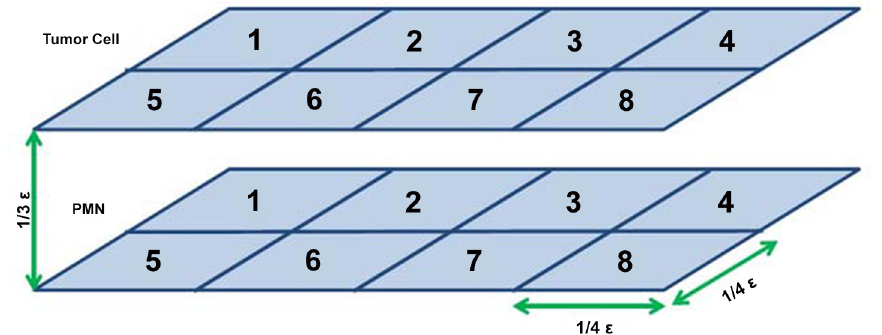
Fig 2. Simplified computational mesh used for model validation. This simplified version of a mesh was used to run the Adhesion model through MATLAB without requiring the input of the detailed geometric mesh used by